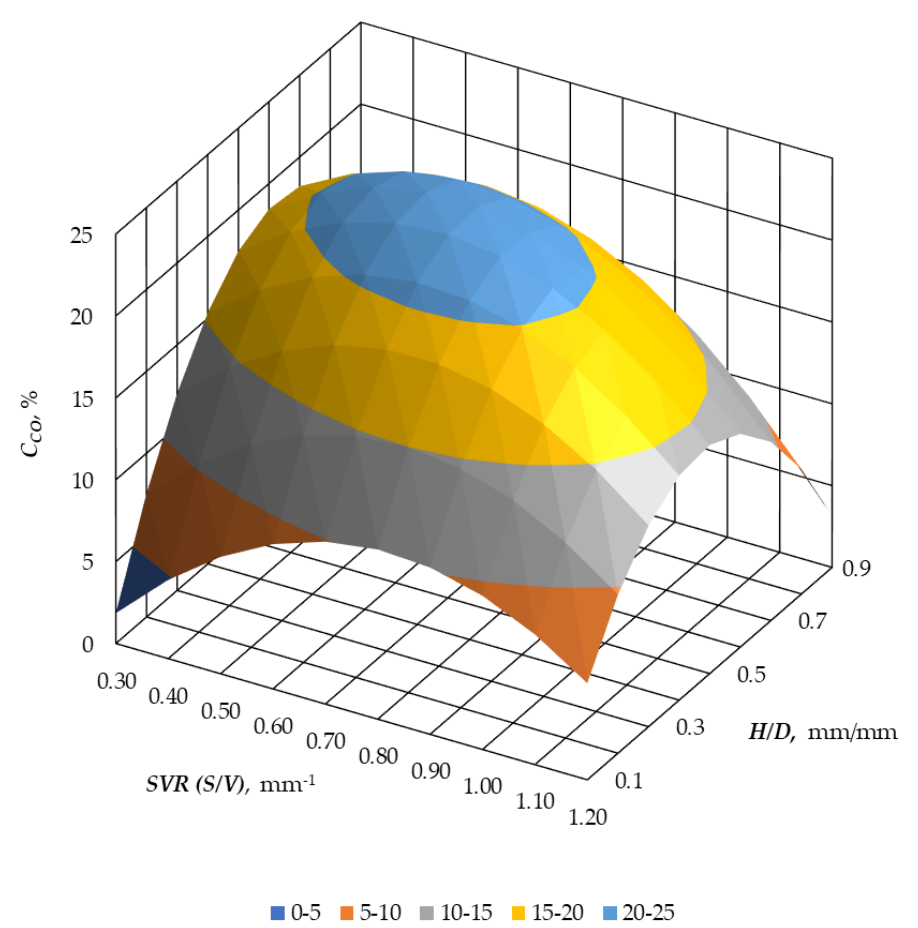
Figure 4. Graphic image of the dependence of CO concentration in the received gas on the ratio indicators of height to the reduction zone diameter ( H/D ) and on the ratio of the full side area ( S ) to the volume ( V ) of a fuel fraction ( SVR ).